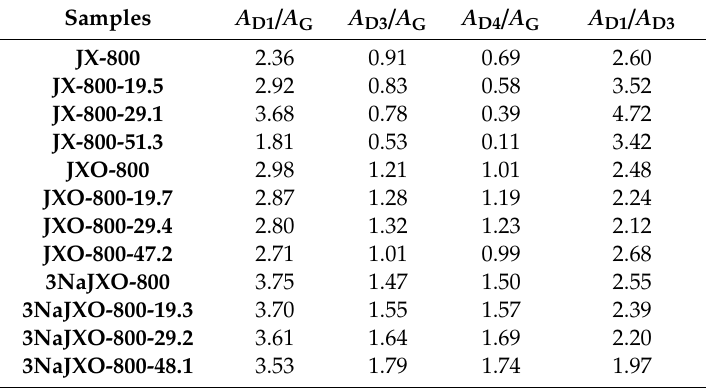
Table 4. Raman data of typical chars at di ff erent burn o ff